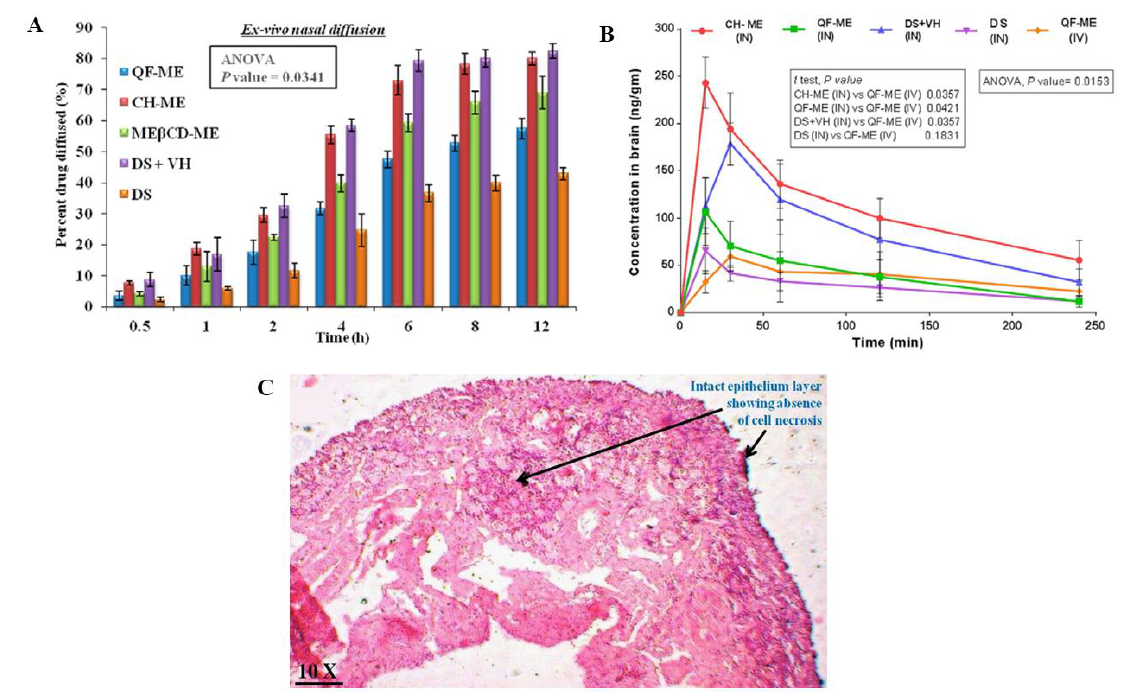
Figure 3. ( A ) Ex-vivo permeation results of quetiapine non-mucoadhesive microemulsion (QF-ME), mucoadhesive microemulsion (with chitosan, CH-ME), cyclodextrin microemulsion (with methyl- β - cyclodextrin, MeβCD -ME), and drug solution (DS); ( B ) brain drug concentration vs. time profiles after intranasal administration of quetiapine non-mucoadhesive microemulsion (QF-ME (IN)), mu- coadhesive microemulsion (with chitosan, CH-ME (IN)) and drug solution (DS (IN)), and intravenous administration of non-mucoadhesive microemulsion (QF-ME (IV)) to rats; ( C ) histopathological examination of a goat nasal mucosa section after exposure to the quetiapine mucoadhesive mi- croemulsion; adapted from Shah et al. [26], reproduced with permission from Elsevier [License Number 5393031395763].